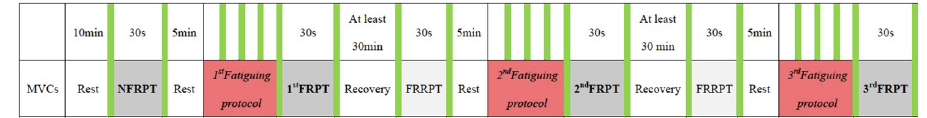
Fig 1. The flow chart of the data collection protocol. The series of shoulder, elbow and lower back fatiguing protocols were performed in random order. The green lines indicate when the Borg CR10 score was asked. MVCs, NFRPT, FRPT, FRRPT stand for maximal voluntary contractions, non-fatigued RPT, Fatigued RPT, Fatigue Recovered RPT, respectively.